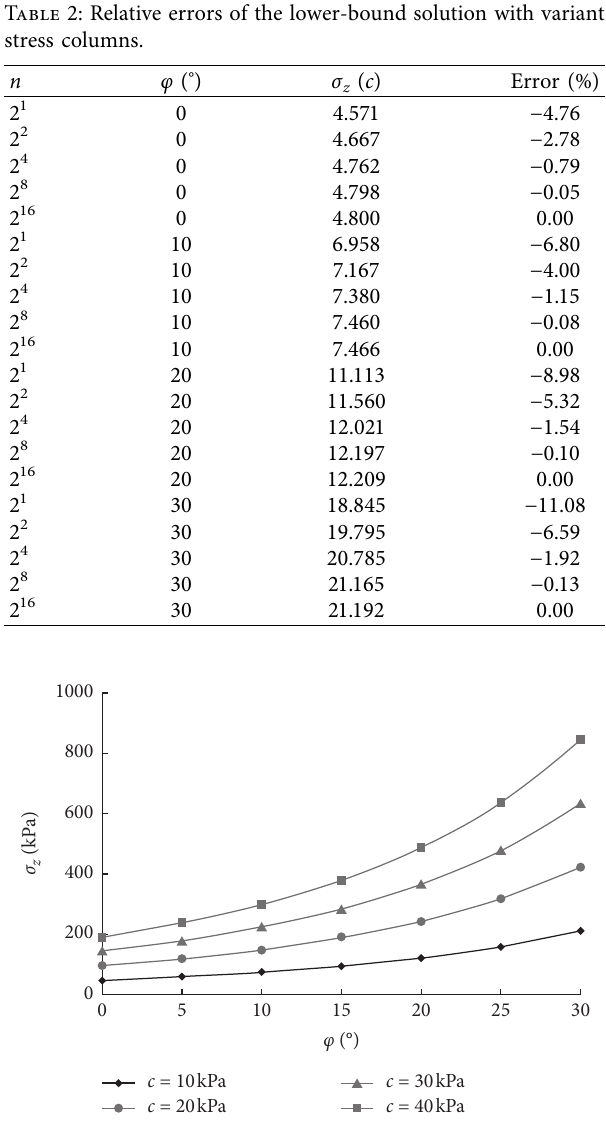
Figure 8: The correlation of bearing capacity and friction